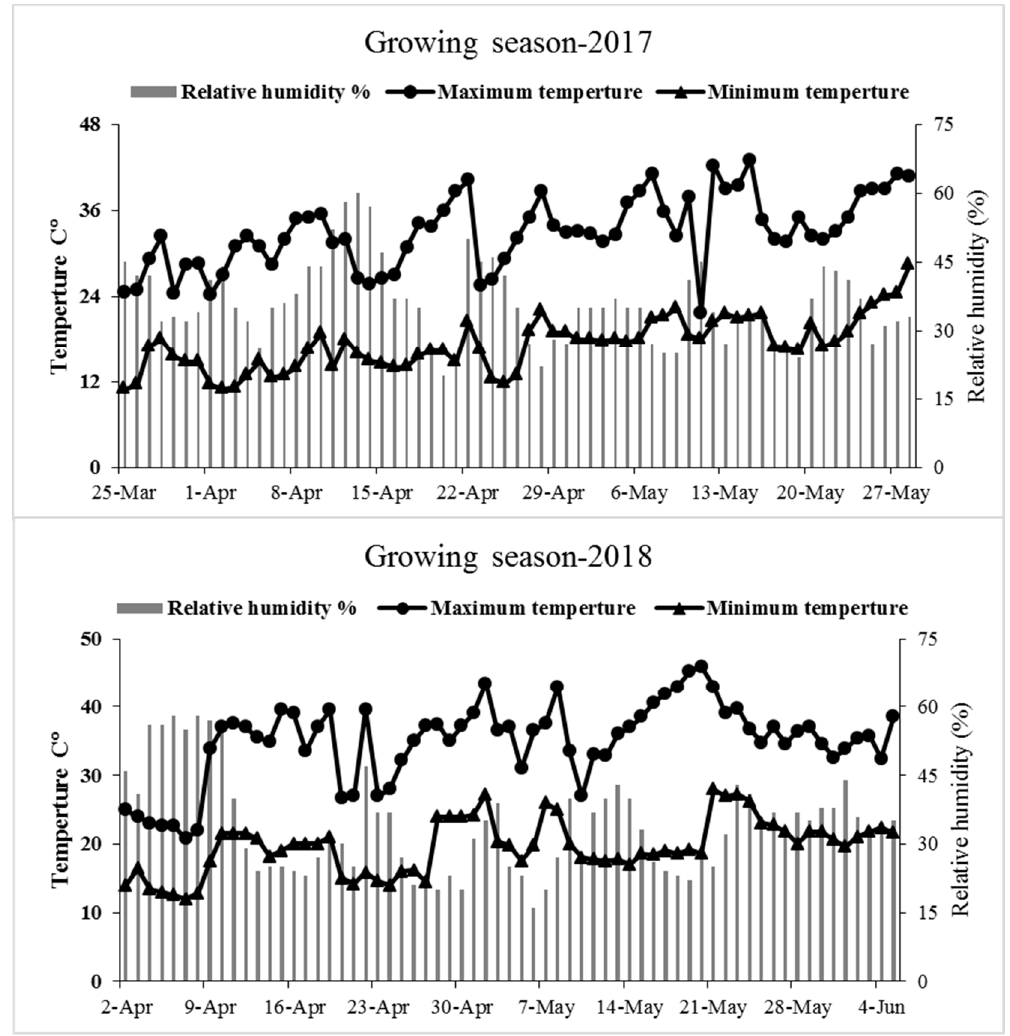
Figure 1. Weather conditions during the two growing periods of Jew’s mellow cultivation.